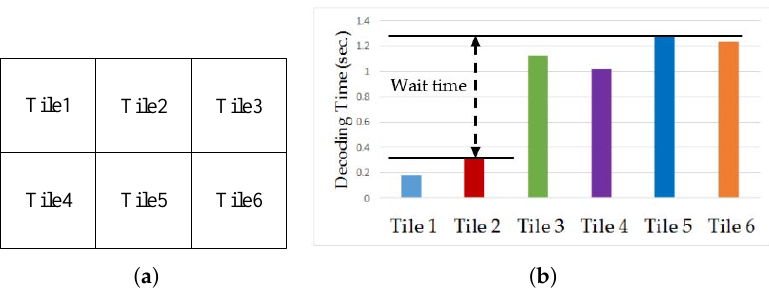
Figure 1. Tile-based HEVC example with ( a ) An example of a frame divided into six tiles, ( b ) Decoding time of each tiles in PeopleOnStreet test sequence.